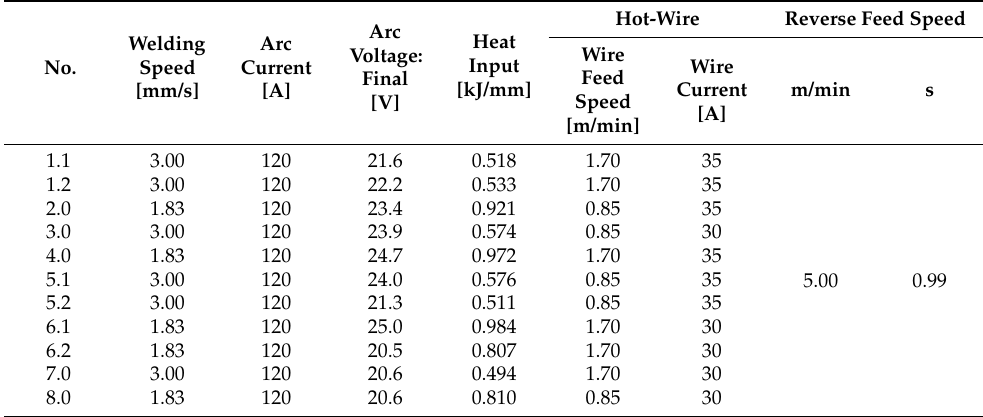
Table 3. The welding experimental conditions of eight welding specimens for hot-wire plasma weld-